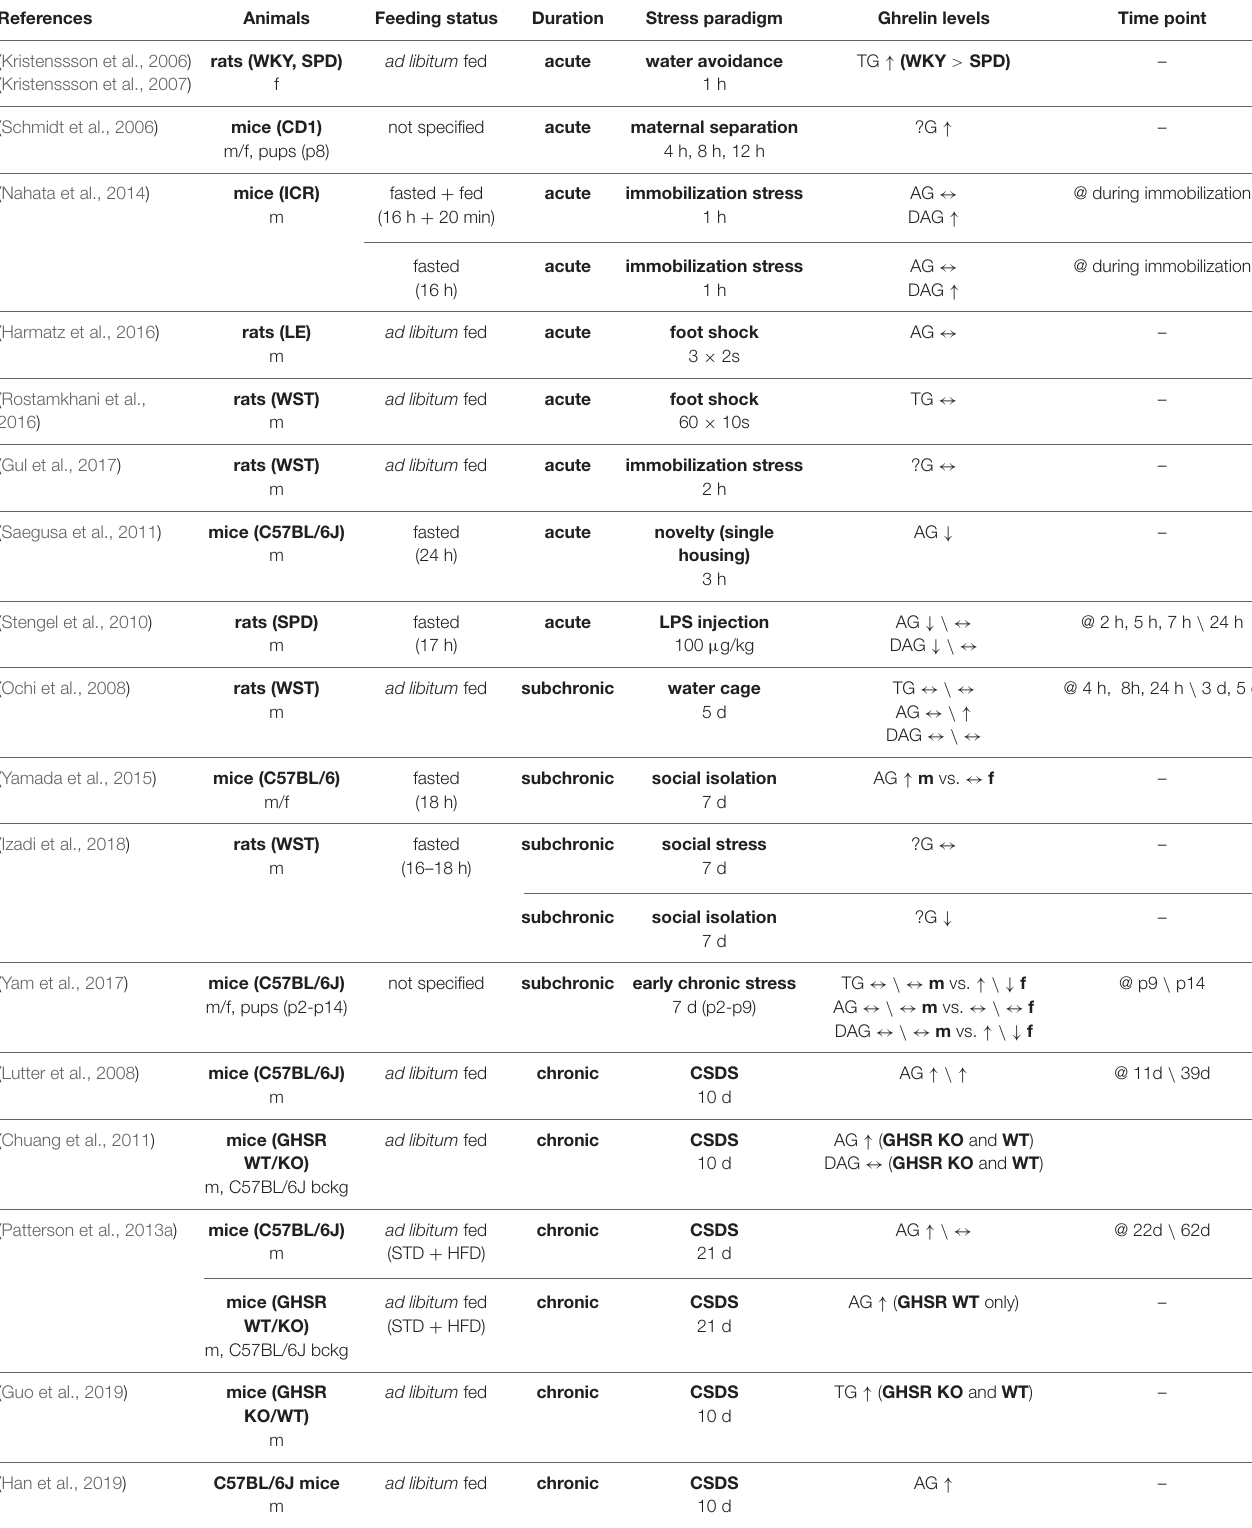
TABLE 1 | Effect of stressors on ghrelin levels in